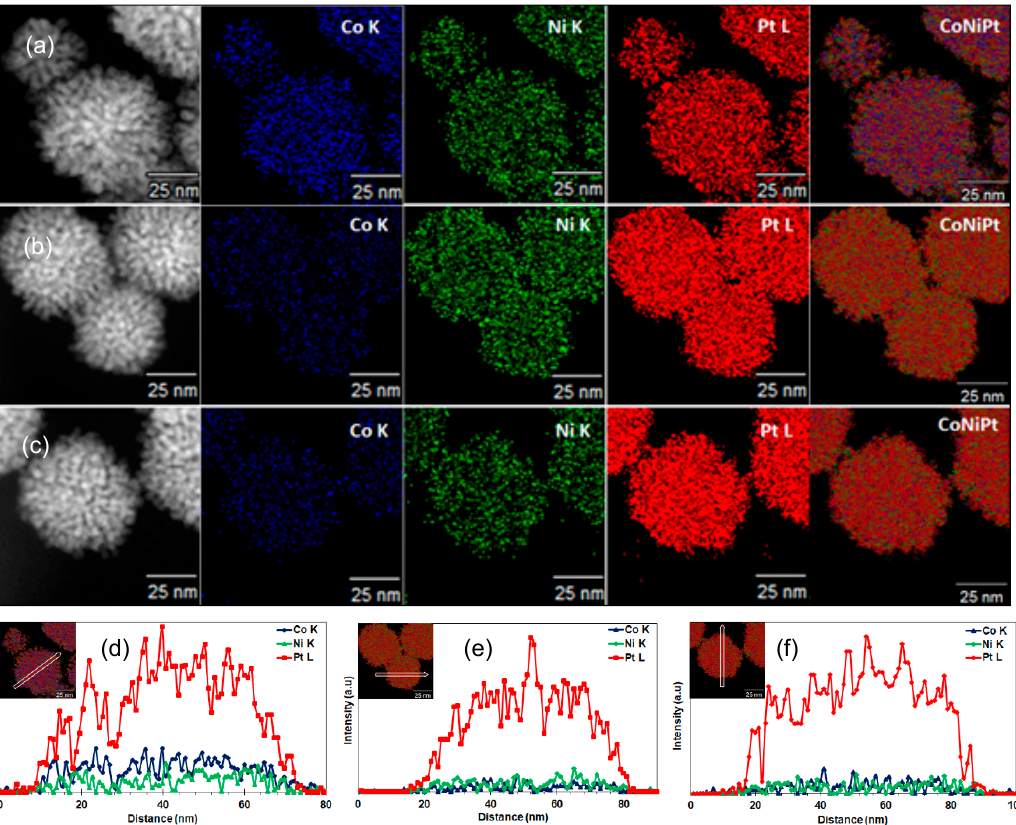
Figure 2. STEM images corresponding to (left to right): secondary electron (SE), bright field (BF), high resolution (HR) BF and FFT diffractograms (generated from the HR-BF images) of the as-synthesized ternary Pt-based nanoalloys with precursor compositions ( a ) Pt 3 (NiCo) 2 ; ( b ) Pt 4 (NiCo); and ( c ) Pt 5 (NiCo). Based on HR-STEM images (( a , b , c ), third column), the measured d -spacings are 0.210 nm, 0.215 nm and 0.220 nm, respectively.